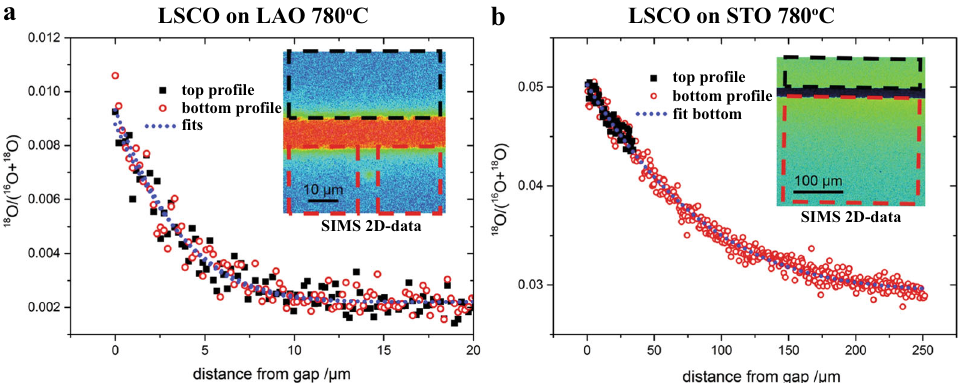
Fig. 3 Exemplary 18 O in-plane diffusion pro fi les of epitaxial LSCO thin fi lms. LSCO is grown with compressive strain on LAO ( a ) and with tensile strain on STO ( b ). The integration area to generate 1D pro fi les was adapted where pinholes or defects were present (see the bottom part of the inlay graphic ( a )). In the case of LSCO/STO at the highest temperature, where very long diffusion lengths were observed, an asymmetric alignment of the gap was chosen to allow for measuring a longer diffusion pro fi le in one direction (see ( b )).